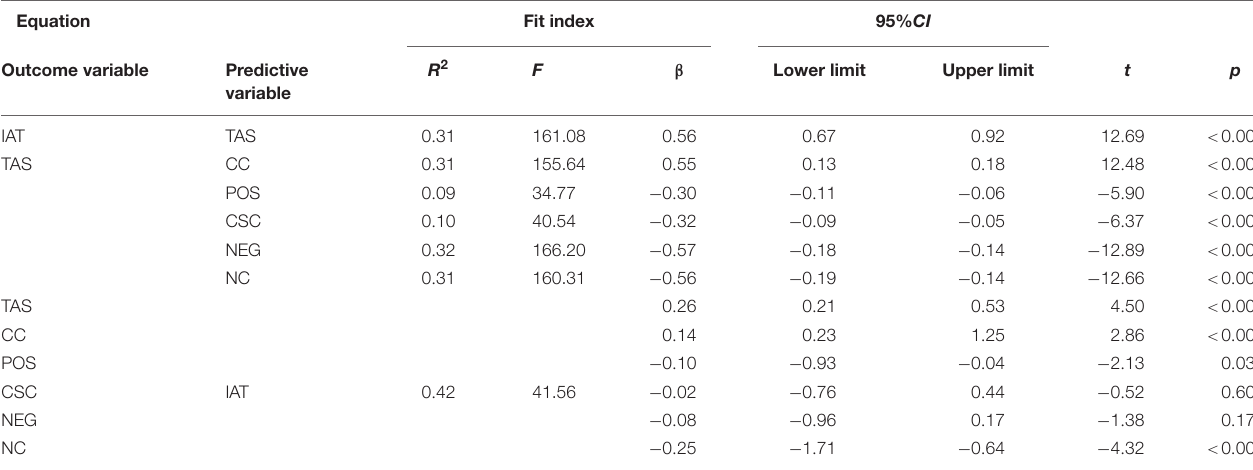
TABLE 2 | Regression analysis of variables in the